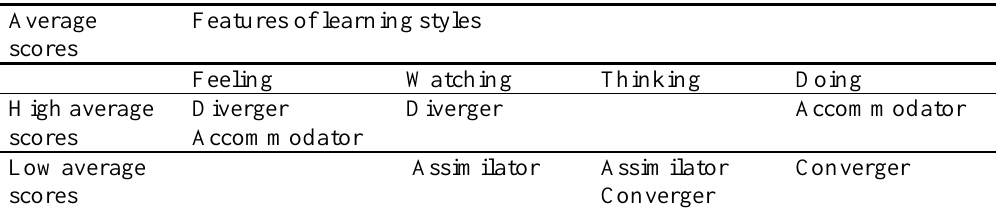
Relationships between Average Scores and Four Learning